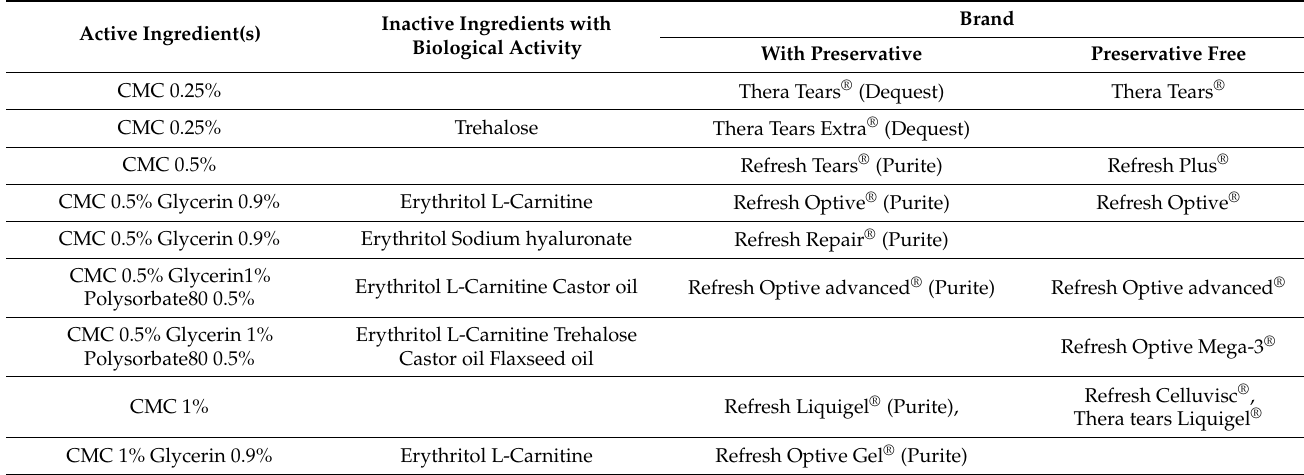
Table 1. Artificial tears containing Carboxymethylcellulose (CMC) as a demulcent.